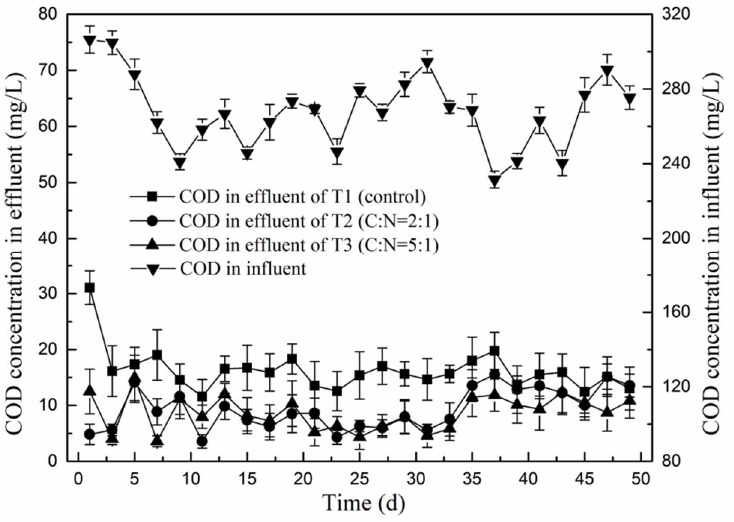
Figure 6. The chemical oxygen demand (COD) concentration in influent of the first stage and in effluent of the second stage of the three experimental setups.